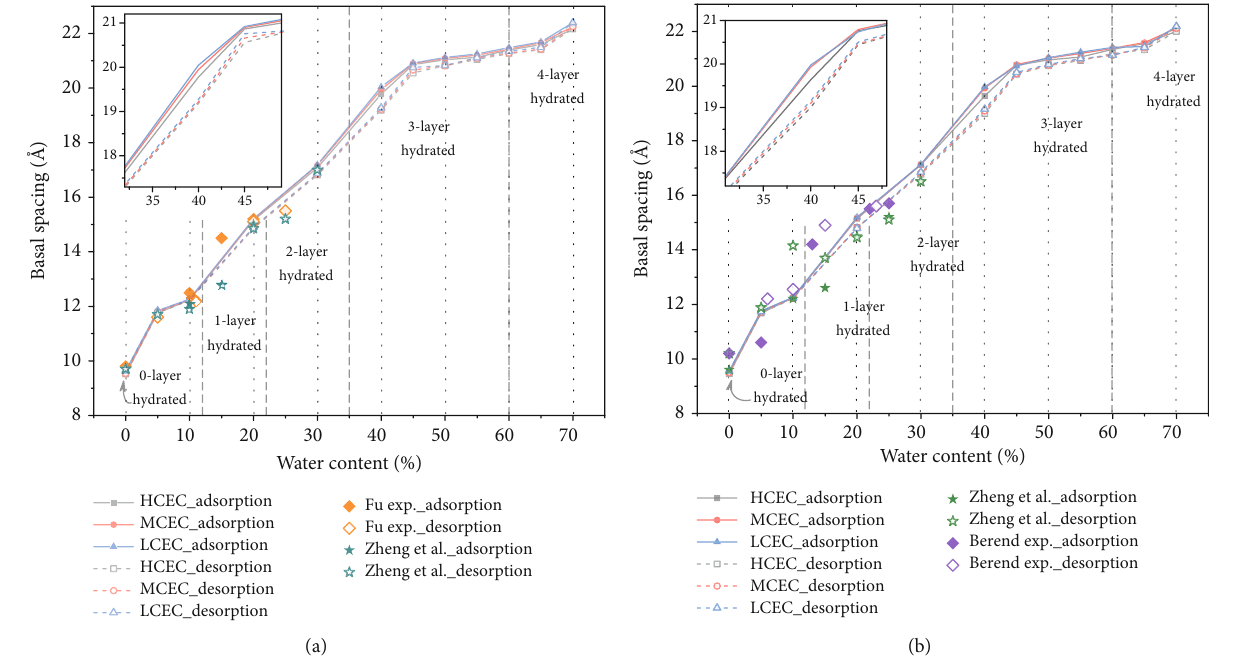
Figure 2: Hysteresis curve of Mnt during swelling and shrinking: (a) Na-Mnt and (b)